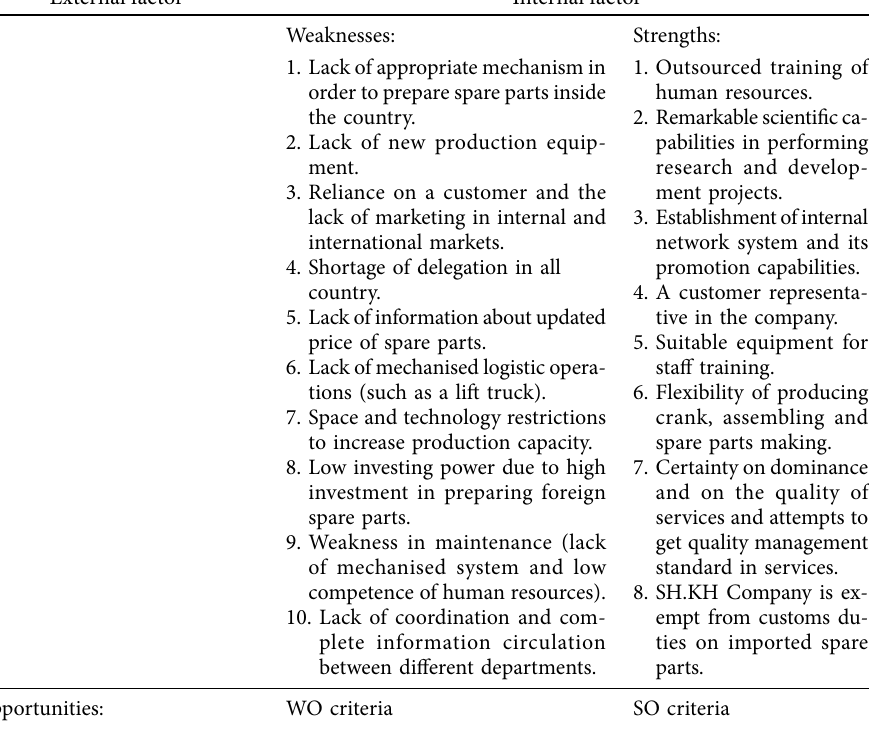
Table 3. SWOT Analysis External